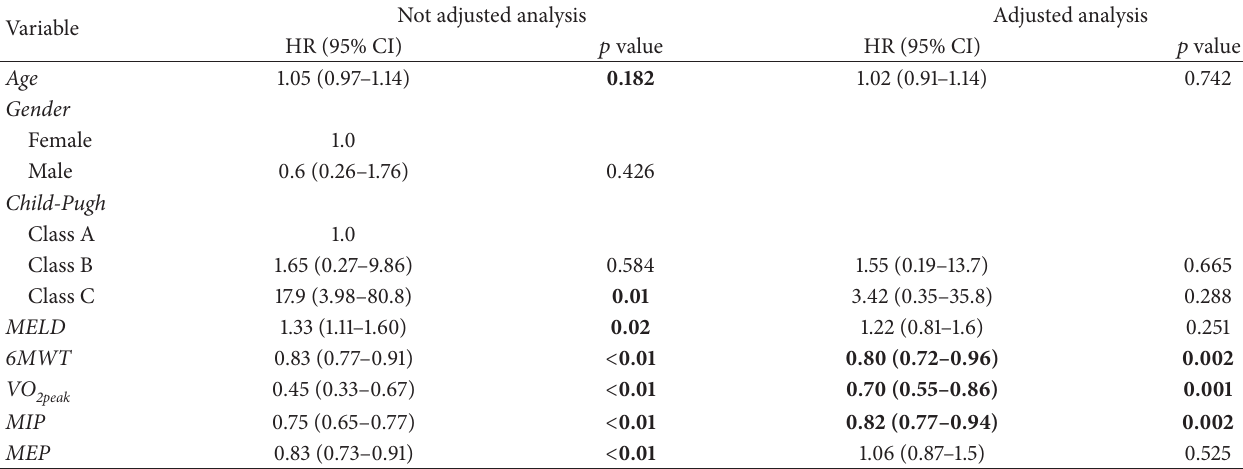
Table 2: Univariate and multivariate analysis of the variables under